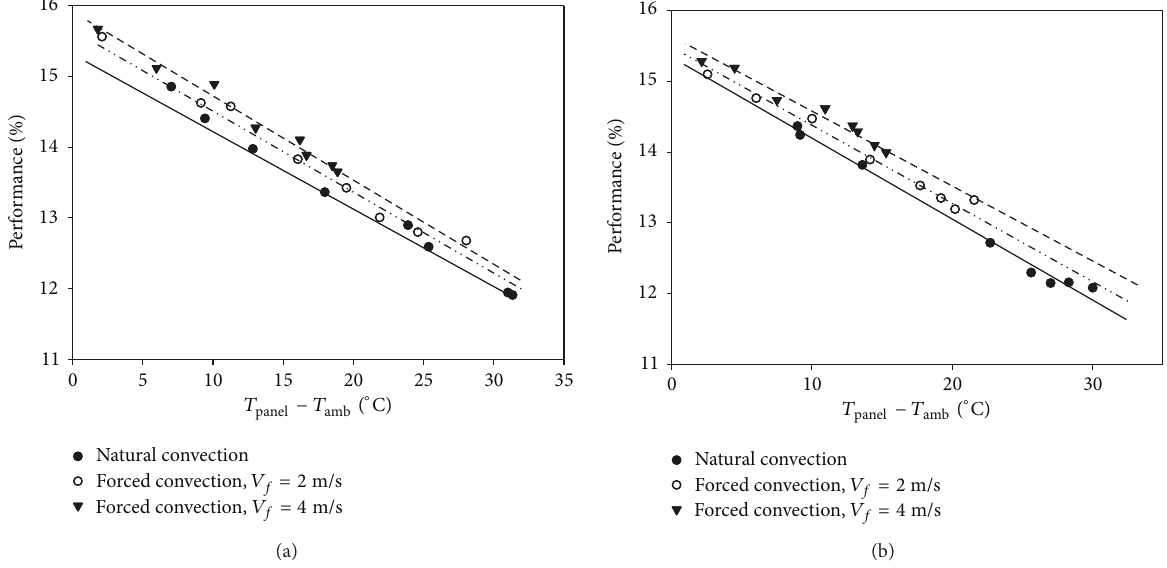
Figure 9: Relationship between panel performance and panel temperature. (a) For the minimum value of the aspect ratio measured (0.0525). (b) For the maximum value of the aspect ratio measured